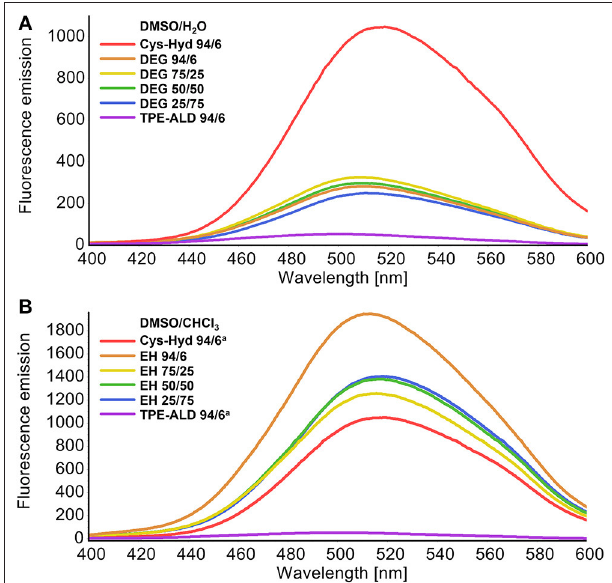
FIGURE 4 | Comparison of fluorescence plots of new cages with reference to the unmodified cage ( L -Cys-Hyd, red plot) and TPE-Ald (violet plot) (0.25mM solutions, excitation wavelength 320nm, range 400–600nm). (A) Plots of DEG-CAGE witch various ratios of DMSO to the H 2 O. (B) Plots of EH-CAGE witch various ratios of DMSO to the CHCl 3